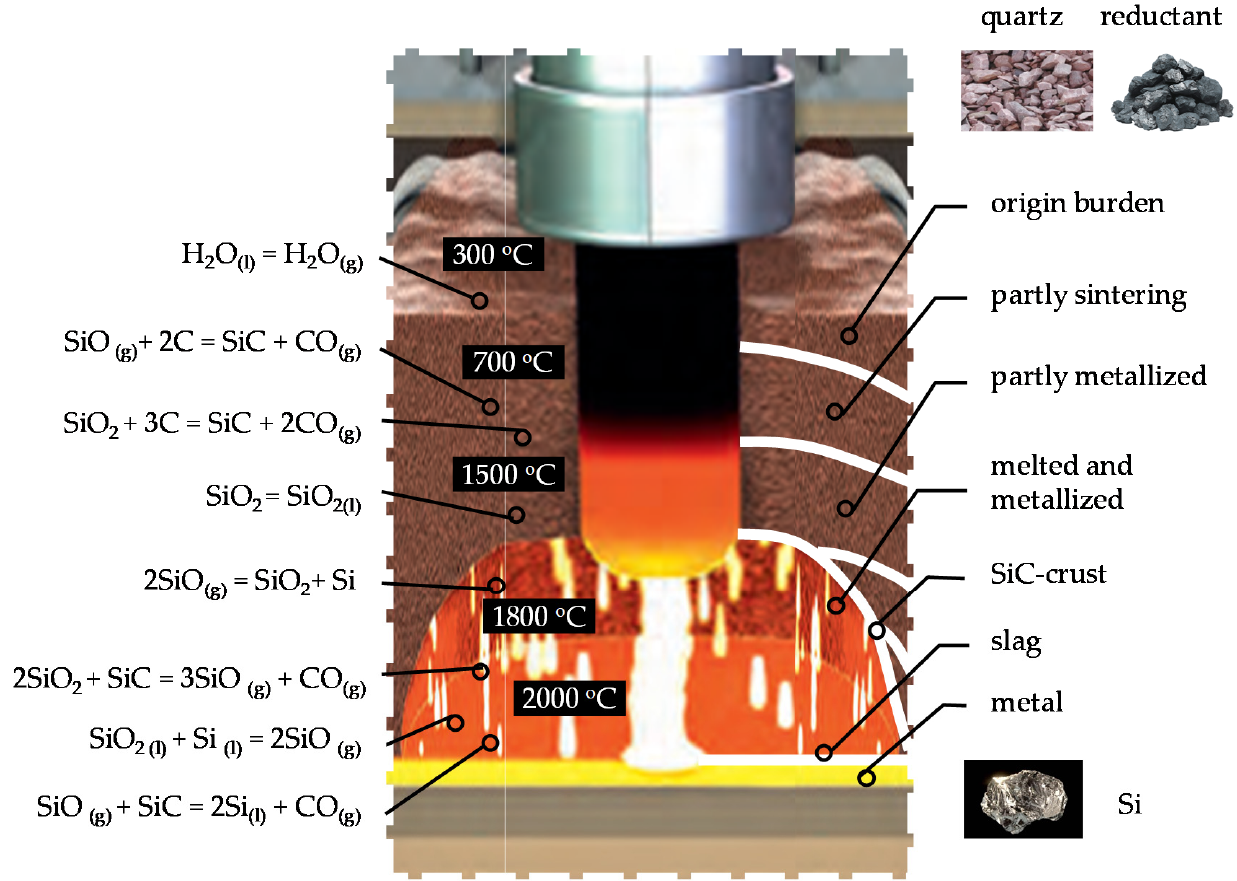
Figure 1. Ilustration of carbothermic reduction of SiO 2 in EAF (created by authors according to [4–6]).